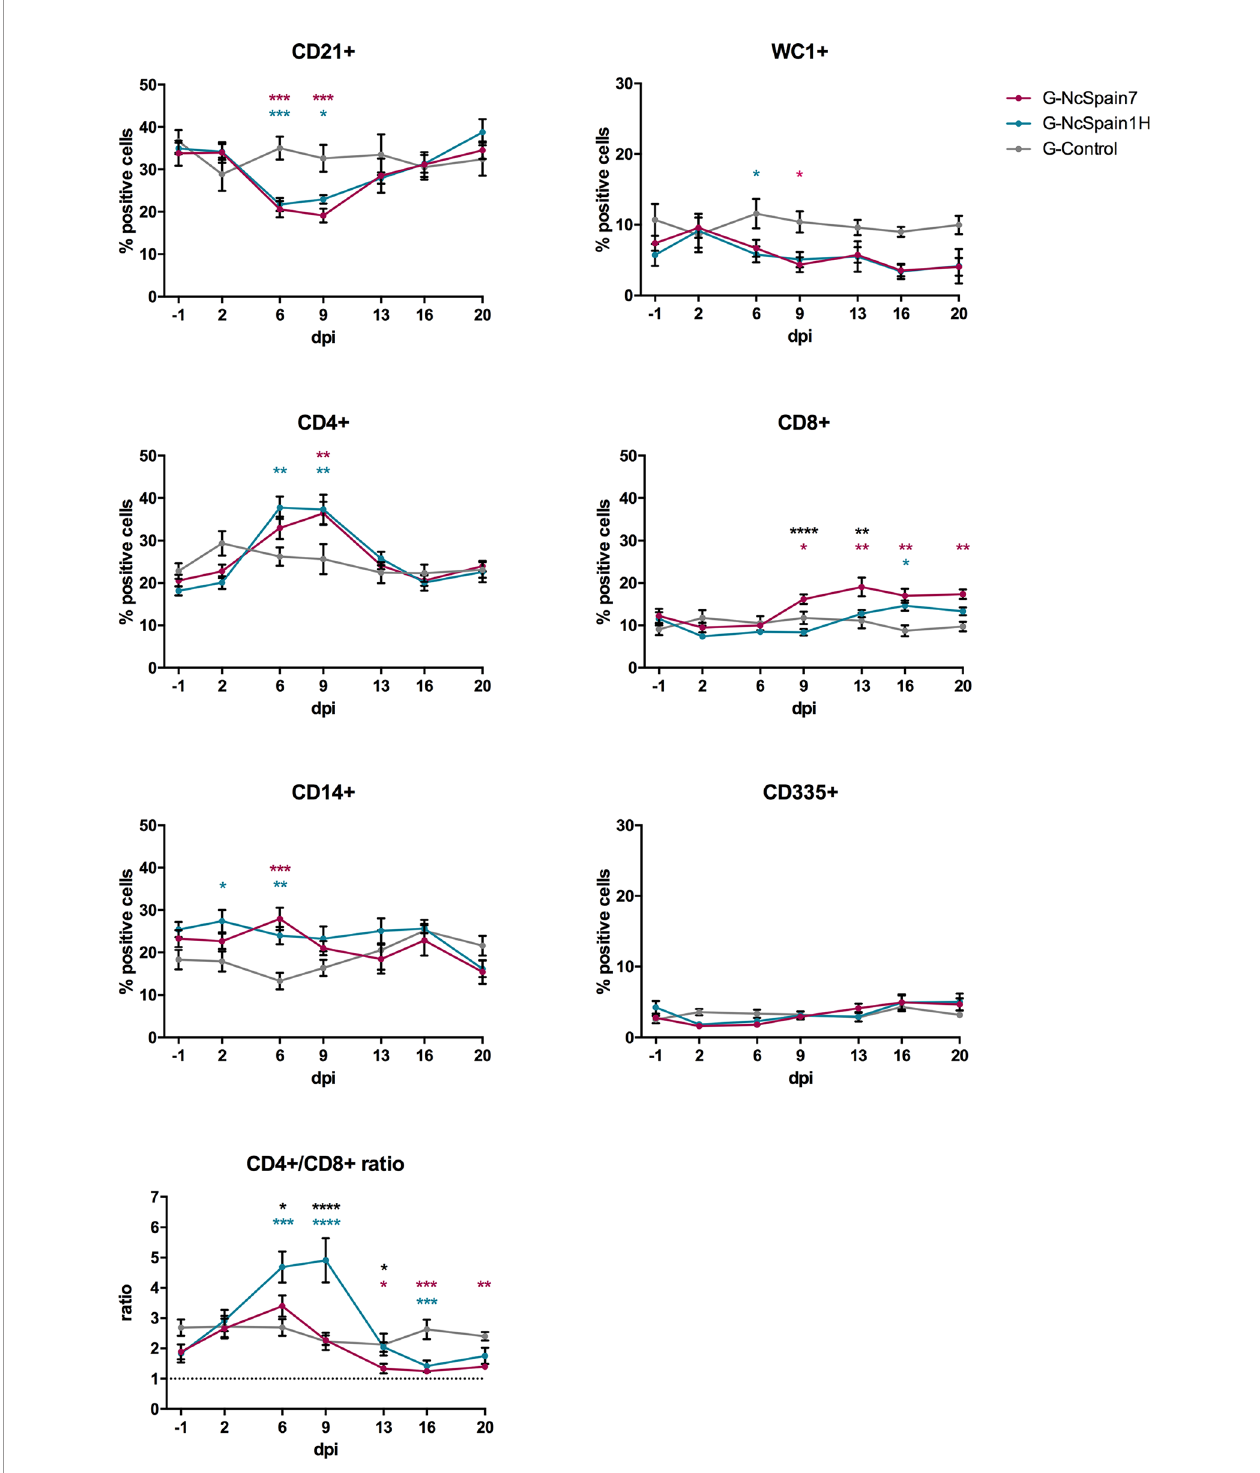
FIGURE 2 | Relative percentage of immune cells in a PBMC population from Nc-Spain7- and Nc-Spain1H-infected heifers. Graphs indicate the relative percentage of cells positive for CD21, WC1, CD4, CD8, CD14 and CD335 surface markers, and CD4+/CD8+ ratio in PBMC obtained from uninfected heifers (G-Control) and heifers challenged with Nc-Spain7 (G-NcSpain7) and Nc-Spain1H (G-NcSpain1H) tachyzoites. The results are represented as the mean+SD. Asterisks indicate signi fi cant differences in G-NcSpain1H versus G-Control comparison (blue), G-NcSpain7 versus G-Control (red) and G-NcSpain1H versus G-NcSpain7 (black). **** P <0.0001, *** P <0.001, ** P <0.01, * P <0.05.